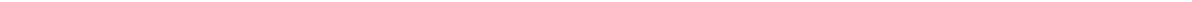
Figure 2 Myosin transiently decorates the cortex of the nascent daughter cells and reorganizes into lateral rings in the presence of trailing chromatids. a Time-lapse images of cells with NC or TC expressing Sqh::GFP during cytokinesis. Half of the cell cortex is shown starting 2 min after anaphase onset. At mid cytokinesis, myosin undergoes outward fl ow from the contractile ring toward the polar cortex (called ef fl ux) in NC and TC cells. The duration of myosin enrichment at Nb and GMC cortices are illustrated above ( yellow line ) and below ( green line ) the images, respectively. The brown arrowheads point to the reorganization of myosin into broad lateral rings, whose constriction forms pseudo cleavage furrows. Time = min:s. b Scheme showing the method for generating kymographs in Fig. 2c. c Kymographs of cortical myosin for cells with NC or TC presented in Fig. 2a. The yellow and green horizontal bars represent the duration of myosin ef fl ux from initiation to disappearance in Nb and GMC, respectively. The brown horizontal bars correspond to the time of contraction of the lateral ectopic myosin rings. The red , brown , and black vertical bars designate the regions where the mean gray intensity of the myosin signal is measured and plotted in Fig. 2d. The x and y axes scale bars correspond to 2 min and 2 µ m, respectively. d Graph showing the average myosin level at three distinct cortical regions (adjacent to the contractile ring ( red curve ), lateral ( brown curve ), and polar ( black curve )) of the GMC over time (left y axis). The GMC elongation index ( cyan curve ) is indicated in the same graph (right y axis). e Scatter dot plot showing the time of myosin ef fl ux initiation from anaphase onset. (NC, n = 57; TC, n = 84). f Scatter dot plot showing the duration of myosin cortical enrichment from initiation of ef fl ux to disappearance. (NC, n = 69; TC, n = 100). g DIC images of cells with NC and TC to illustrate the calculation of the elongation index plotted in Fig. 2h, j, k, which correspond to the ratio: length ( L ) ( red double arrow ) over width ( W ) ( green double arrow ) of each daughter cell. h Scatter dot plot showing the distribution of the elongation index of the GMC and Nb daughter cells with NC or TC. i Still images of live cells expressing H2Az::mRFP ( red ) and Sqh::GFP ( gray ) with TC and the corresponding scheme below. These cells are examples of cells where the length of the trailing chromatid was measured ( black dashed line ) at the time the elongation index was calculated and plotted in Fig. 2j. The colored dots correspond to the colored dots plotted in Fig. 2j. j Graph showing the correlation between the length of the TC and the elongation index for the GMC. The colored dots correspond to the cells shown in Fig. 2i. k Graph showing the GMC elongation index plotted over time for NC and TC that illustrates the fi rst (1st E) and second elongation (2nd E). The green horizontal bars above the graph correspond to the average duration of myosin cortical enrichment for NC and TC, respectively. The vertical green dotted lines correspond to the average initiation of ef fl ux and disassembly of myosin from the cortex. l Frequency of cells with NC and TC that bleb. The DIC image illustrates a cell with blebs ( red stars ). All cells are oriented so that the daughter Nb is apical and the daughter GMC is basal. Scale bars = 5 µ m. n = number of cells. The mean ± 95% CI is presented for all graphs and scatter dot plots. A Mann-Whitney test was used to calculate P values (**** corresponds to P <